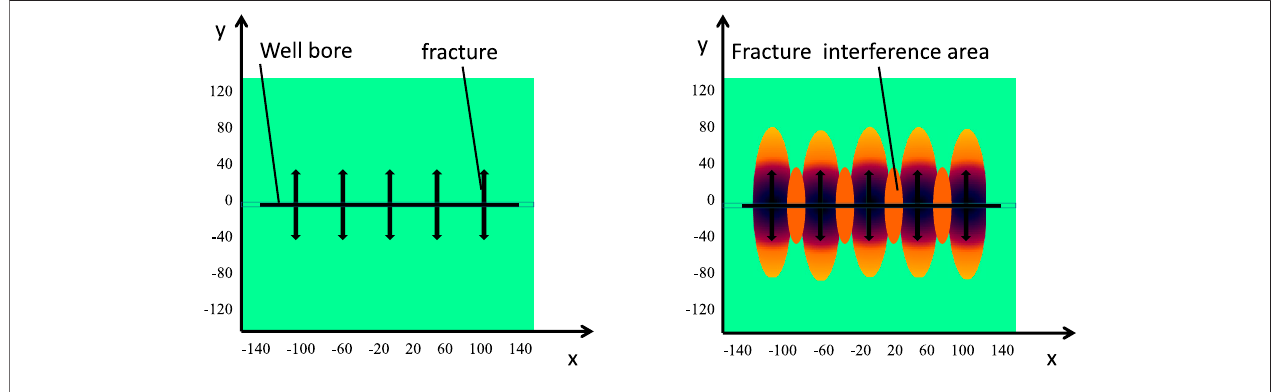
FIGURE 3 | Diagram of interfracture interference in horizontal wells.